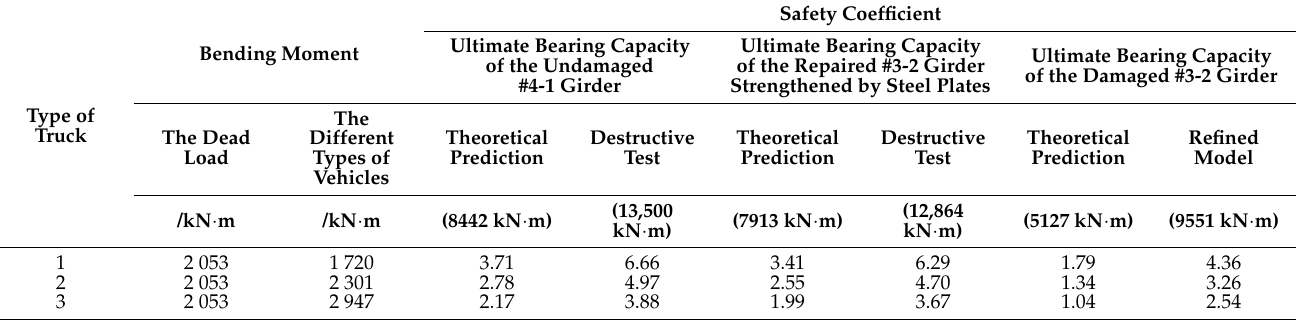
Table 6. Safety coe ffi cient for di ff erent types of vehicles.